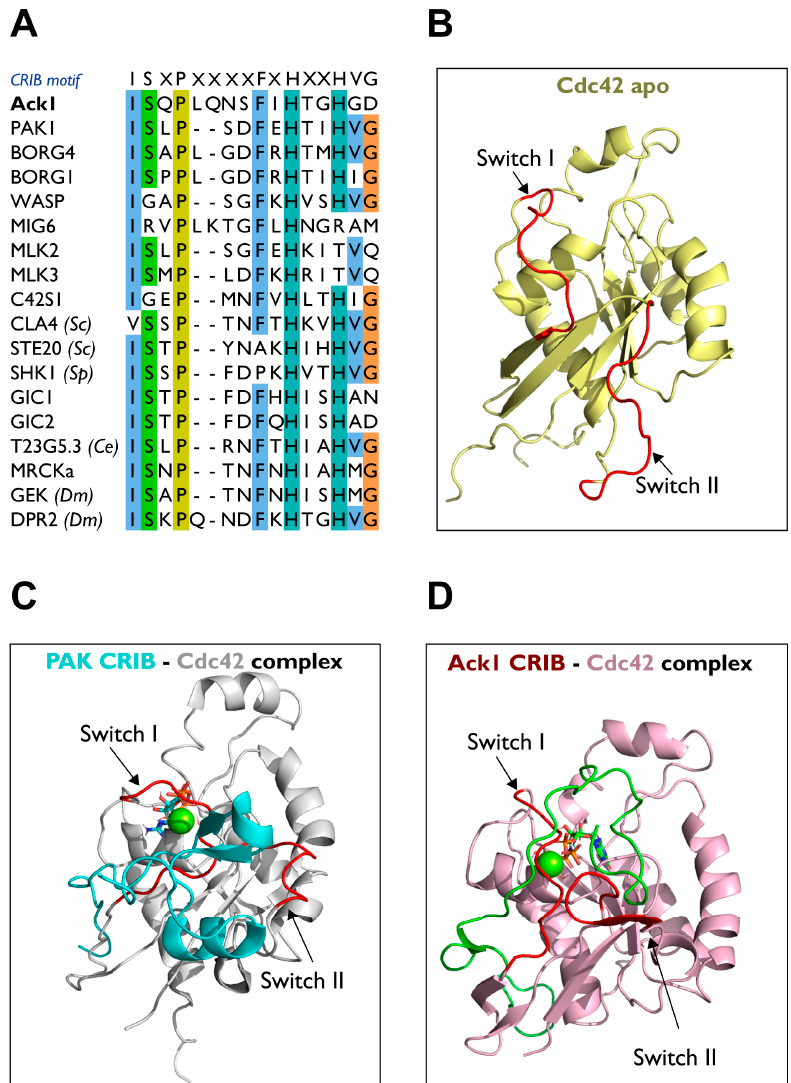
Figure 11. Structure of the Cdc42-CRIB complex. ( A ) Sequence alignment of the CRIB motifs of human Ack1 and other proteins. Sc, Saccharomyces cerevisiae (budding yeast); Sp, S. pombe (fission yeast); Dm, D. melanogaster ; Ce, C. elegans . ( B ) Structure of apo-Cdc42 (PDB: 1AJE; pale yellow). ( C ) The PAK-Cdc42 complex (PDB: 1E0A, PAK CRIB, cyan; Cdc42, grey). ( D ) Ack1-Cdc42 complex (PDB: 1CF4; Ack1 CRIB, green; Cdc42, pink). Switches I and II are highlighted in